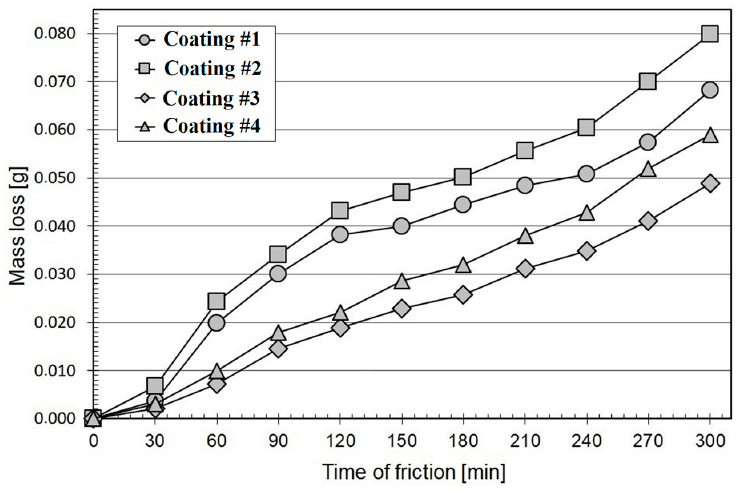
Figure 11. Wear resistant of produced Fe–B coatings and Fe–B–B 4 C–Si produced using the same scanning speed of laser beam equal to 600 mm/min and different laser beam power.